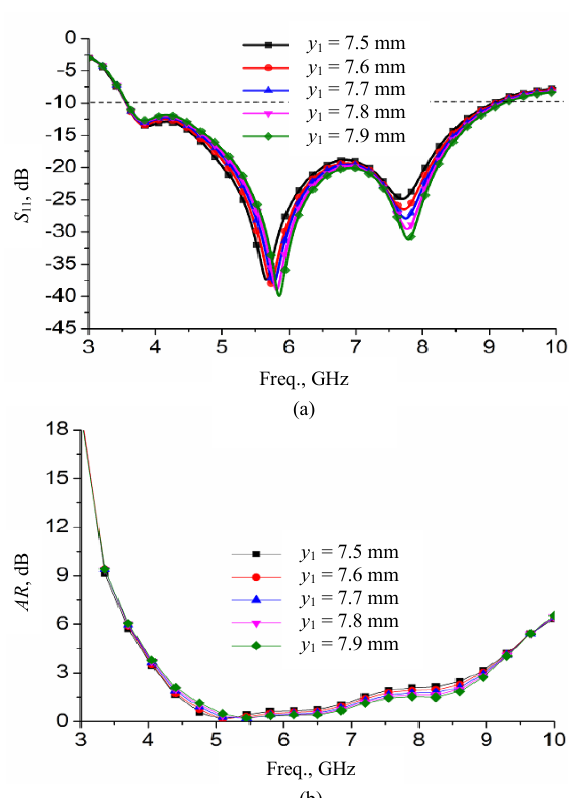
Fig. 7. Effect of ‘ y 1 ’ on impedance bandwidth and axial ratio.